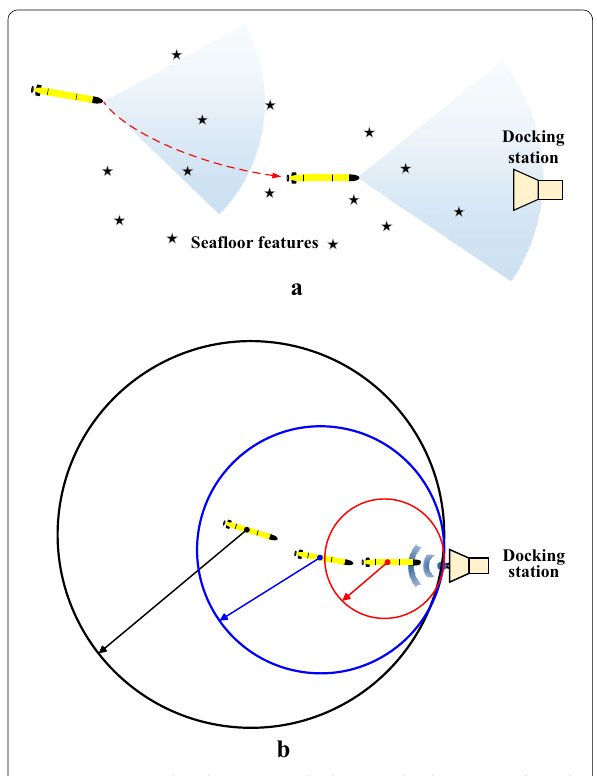
Figure 9 Potential and promising docking methods: ( a ) sonar-based SLAM; ( b ) range-only